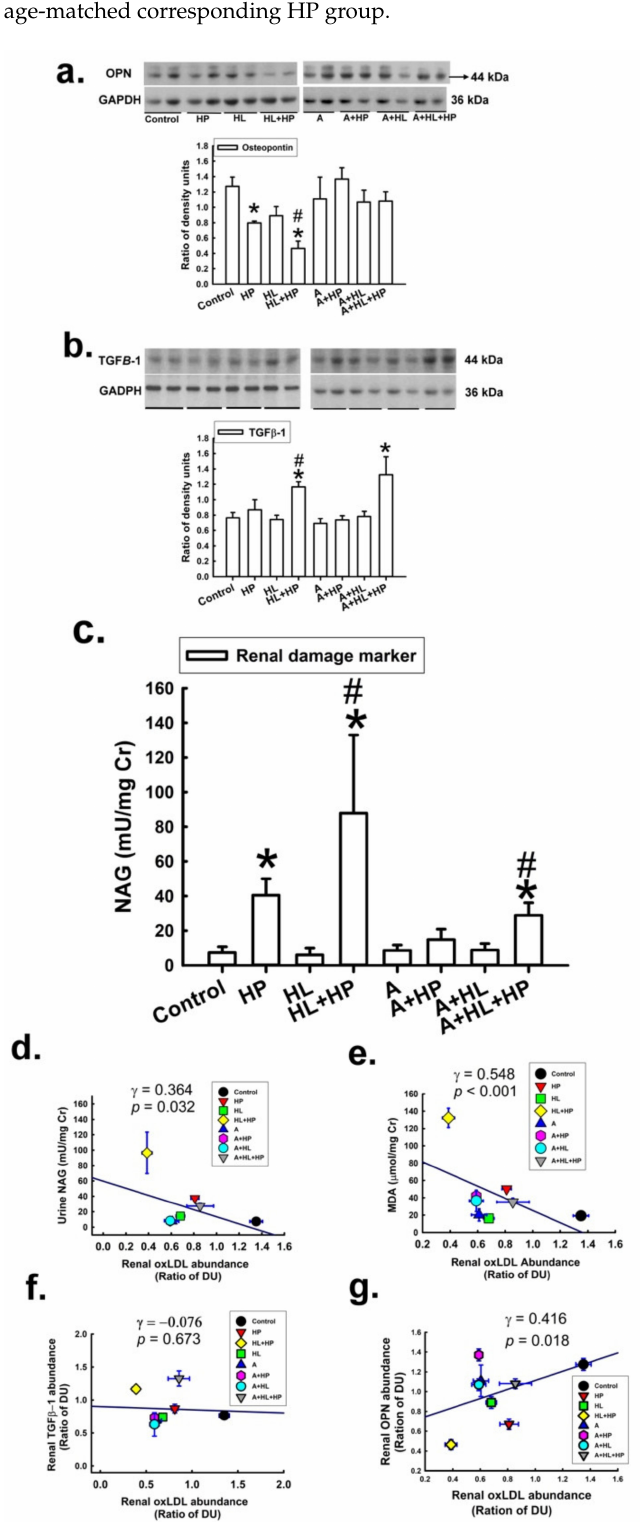
Figure 6. Impact of atorvastatin on the expression of ( a ) the antilithic molecule osteopontin (OPN), * versus control; # versus HL, ( b ) transforming growth factor (TGF β -1, is a critical mediator of